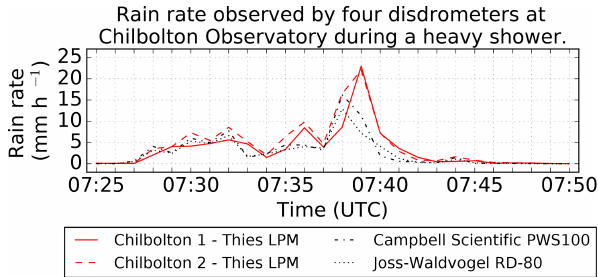
Figure 12. Rain rate measured by four instruments during a heavy rain event at NFARR Atmospheric Observatory, Chilbolton, Eng- land, on 23 March 2017. The total accumulated rain depth over the 26min for each instrument is as follows: Chilbolton 1 (1.481mm); Chilbolton 2 (1.847mm); PWS100 (1.237mm); JWD (1.090mm). Each instrument has been normalized for sampling area and bin widths. Both of the Thies LPMs have a higher total rain rate than the PWS100 and JWD. The difference in rain rate between both of the Thies LPMs and the PWS100 and JWD is greatest during the most intense precipitation, which may be evidence of droplets splashing from the instrument housing into the measuring beam.